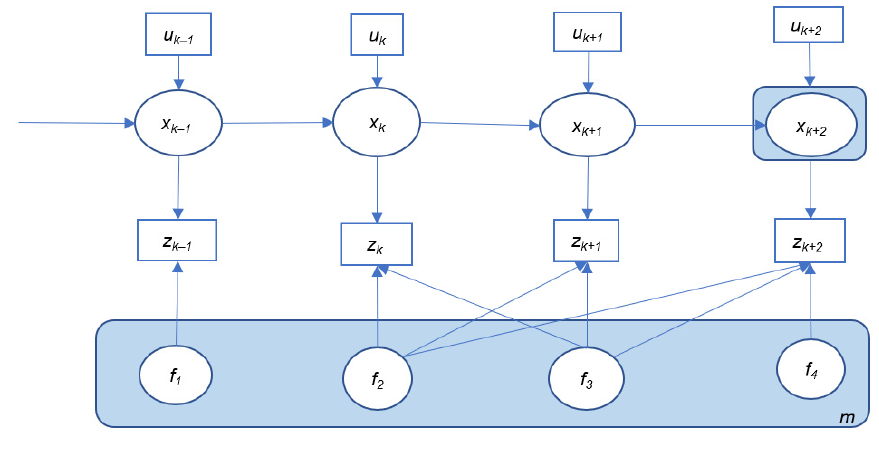
Figure 2. Description of online SLAM.